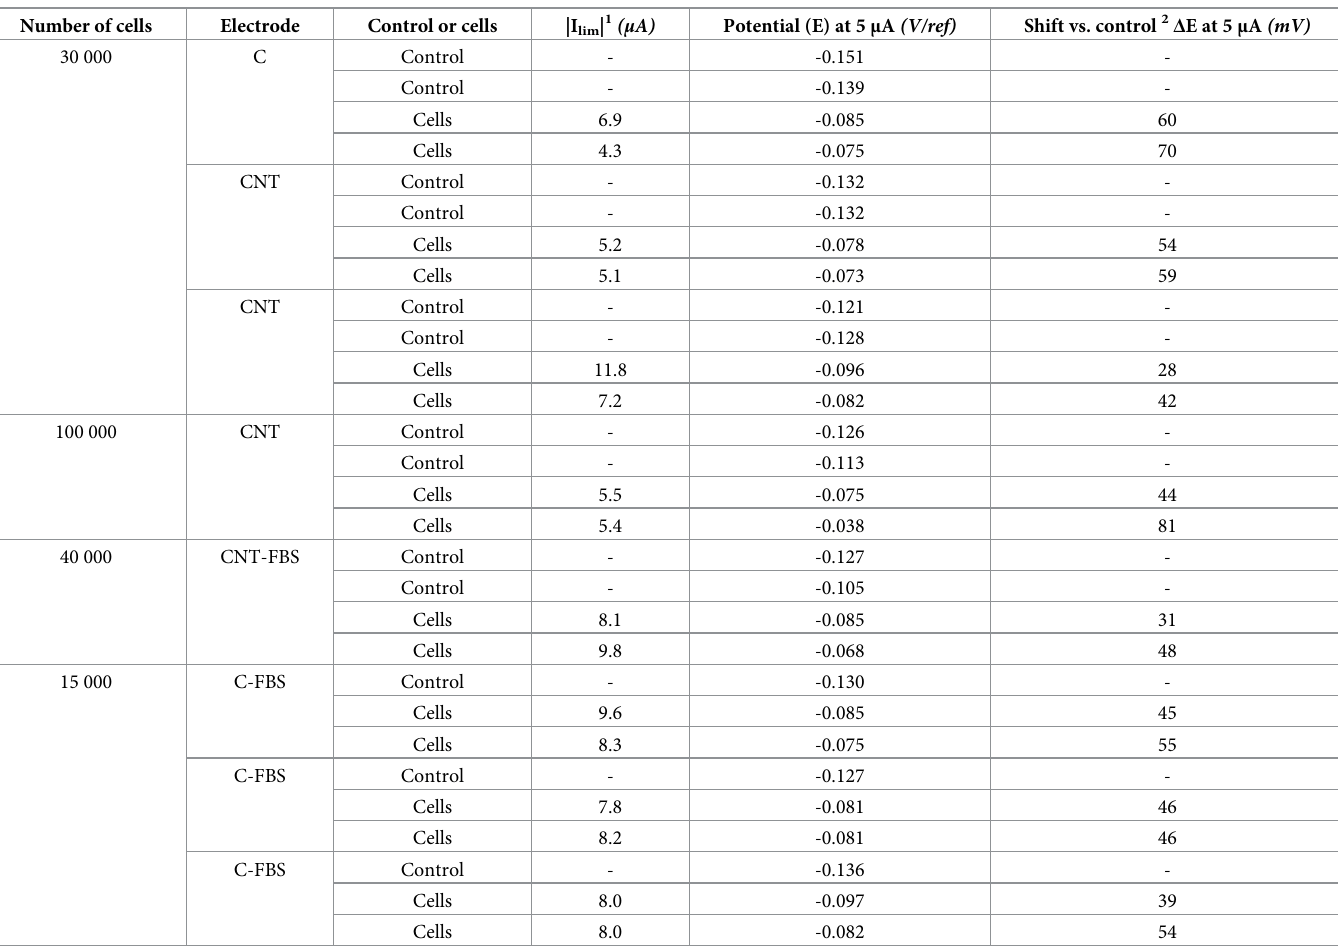
Table 1. Analysis of the reactors incubated for 72 hours with Vero cells. Number of